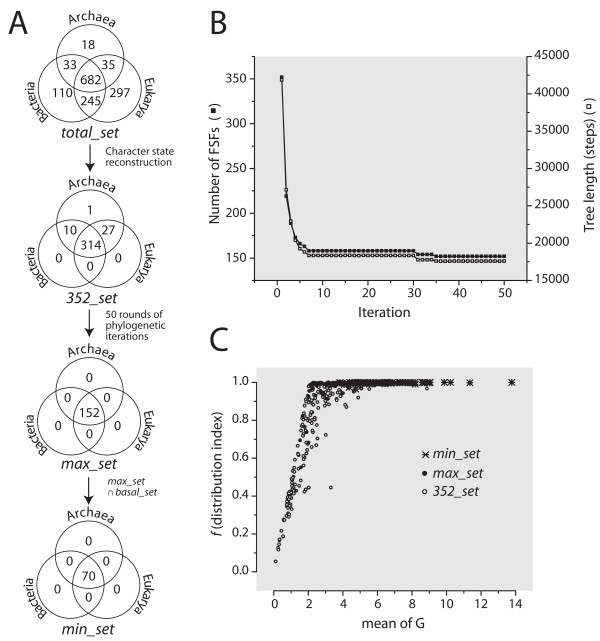
Defining urancestral FSFs by serial and iterative phylogenetic and character state reconstruction analysis. A. Venn diagrams with seven cells describing the distribution of FSFs in the three superkingdoms of life, Archaea (A), Bacteria (B), and Eukarya (E), in sets derived from iterative refinement. The Venn diagram in the top shows the taxonomic occurrence of the modern set of 1,420 FSFs in the 420 FL organisms analyzed in this study. The Venn diagram of the 352_set describes the distribution of 352 FSFs that are plesiomorphic and positioned at the root branch of the proteome tree of Figure 1A. The Venn diagram of the urancestral max_set describes the distribution of a minimal set of 152 FSFs that was recovered by serial and iterative phylogenetic and character state reconstruction analysis (see B). The set was defined by identifying a tree of proteomes with minimal length, extracting FSF that are plesiomorphic and basal, and updating the character set of FSFs for further phylogenetic analysis in 30 chains of 50 rounds of iterations each. The Venn diagram of the min_set describes the distribution of 70 FSFs identified by the intersection of the max_set and a basal_set of 130 FSFs that are present in the three superkingdoms and are placed at the base of the tree of domain structure described in Figure 1B. B. Change in the length of trees and number of FSFs recovered in individual iterations of chain number 26. For the ith iteration, the left y-axis indicates the number of distinct FSFs that appear in the root branch of the (i-1)th proteome tree and the right y-axis represents the lengths of the reconstructed tree. The numbers of FSFs converged into a single value after the 35th iteration. The arrow points to the iteration that generates the most parsimonious trees with the minimal tree length in the chain. C. Correlation between mean of G and f indexes for the different sets of FSFs.